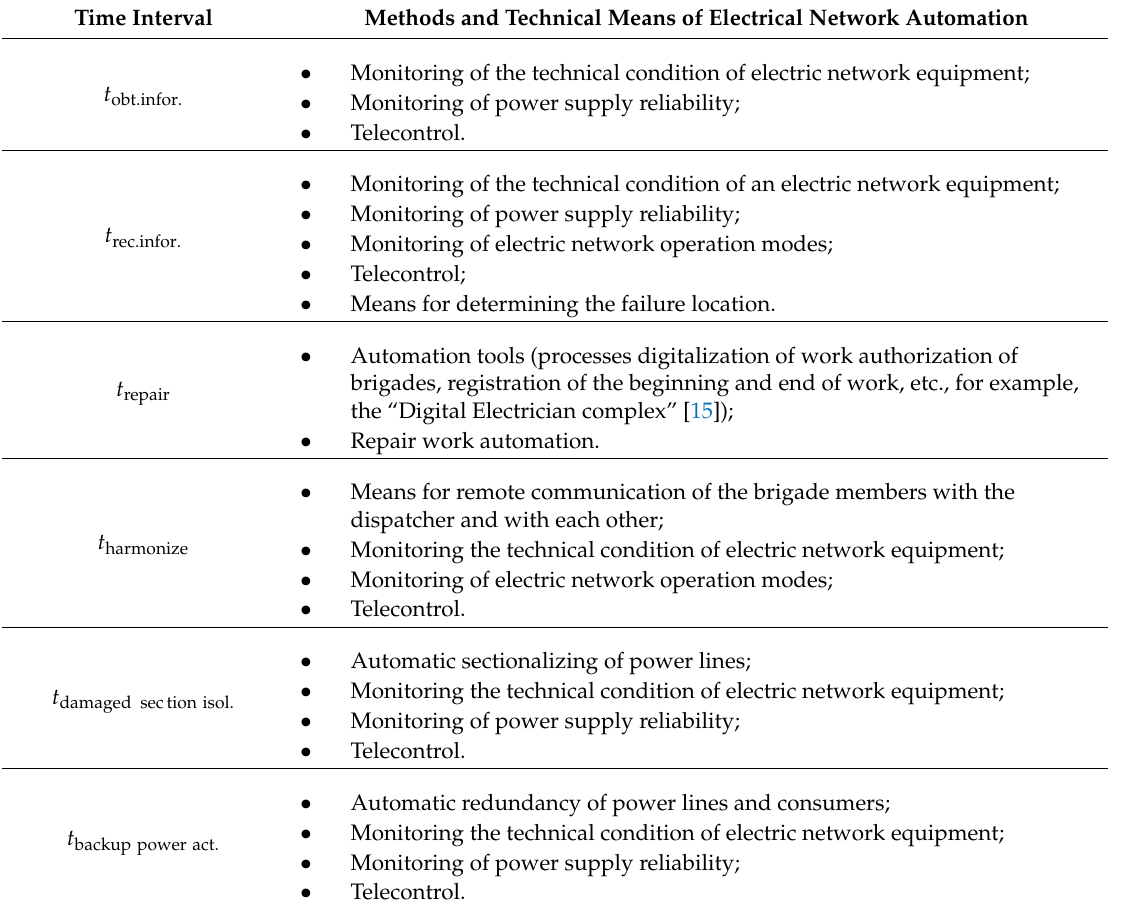
Table 5. Methods and technical means of electrical network automation for reducing the power supply (PS) restoration